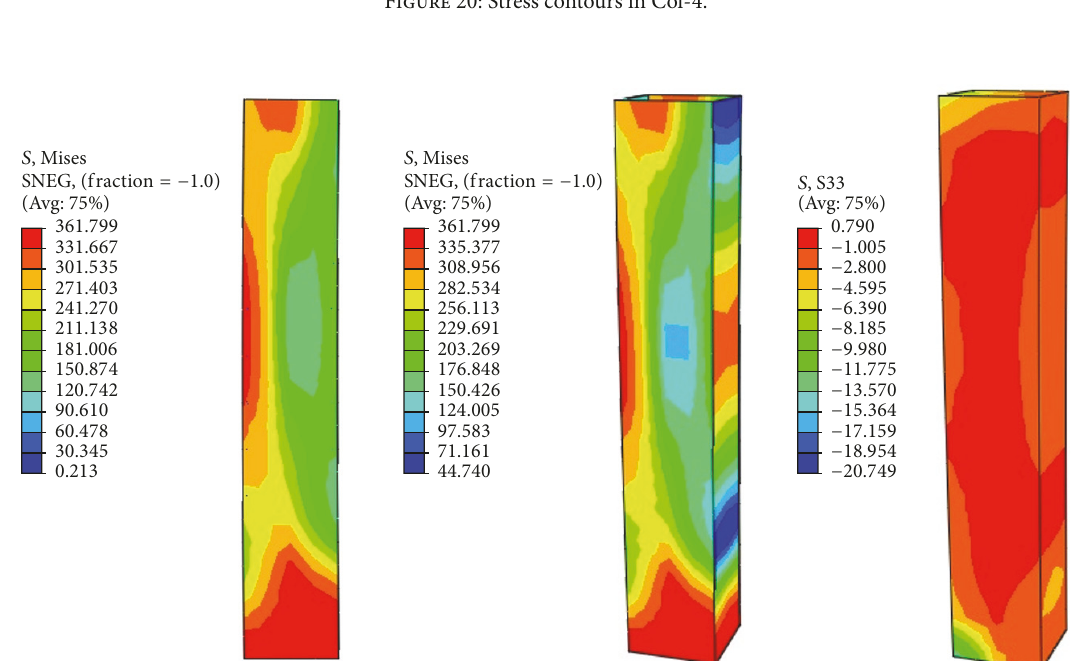
Figure 20: Stress contours in Col-4.